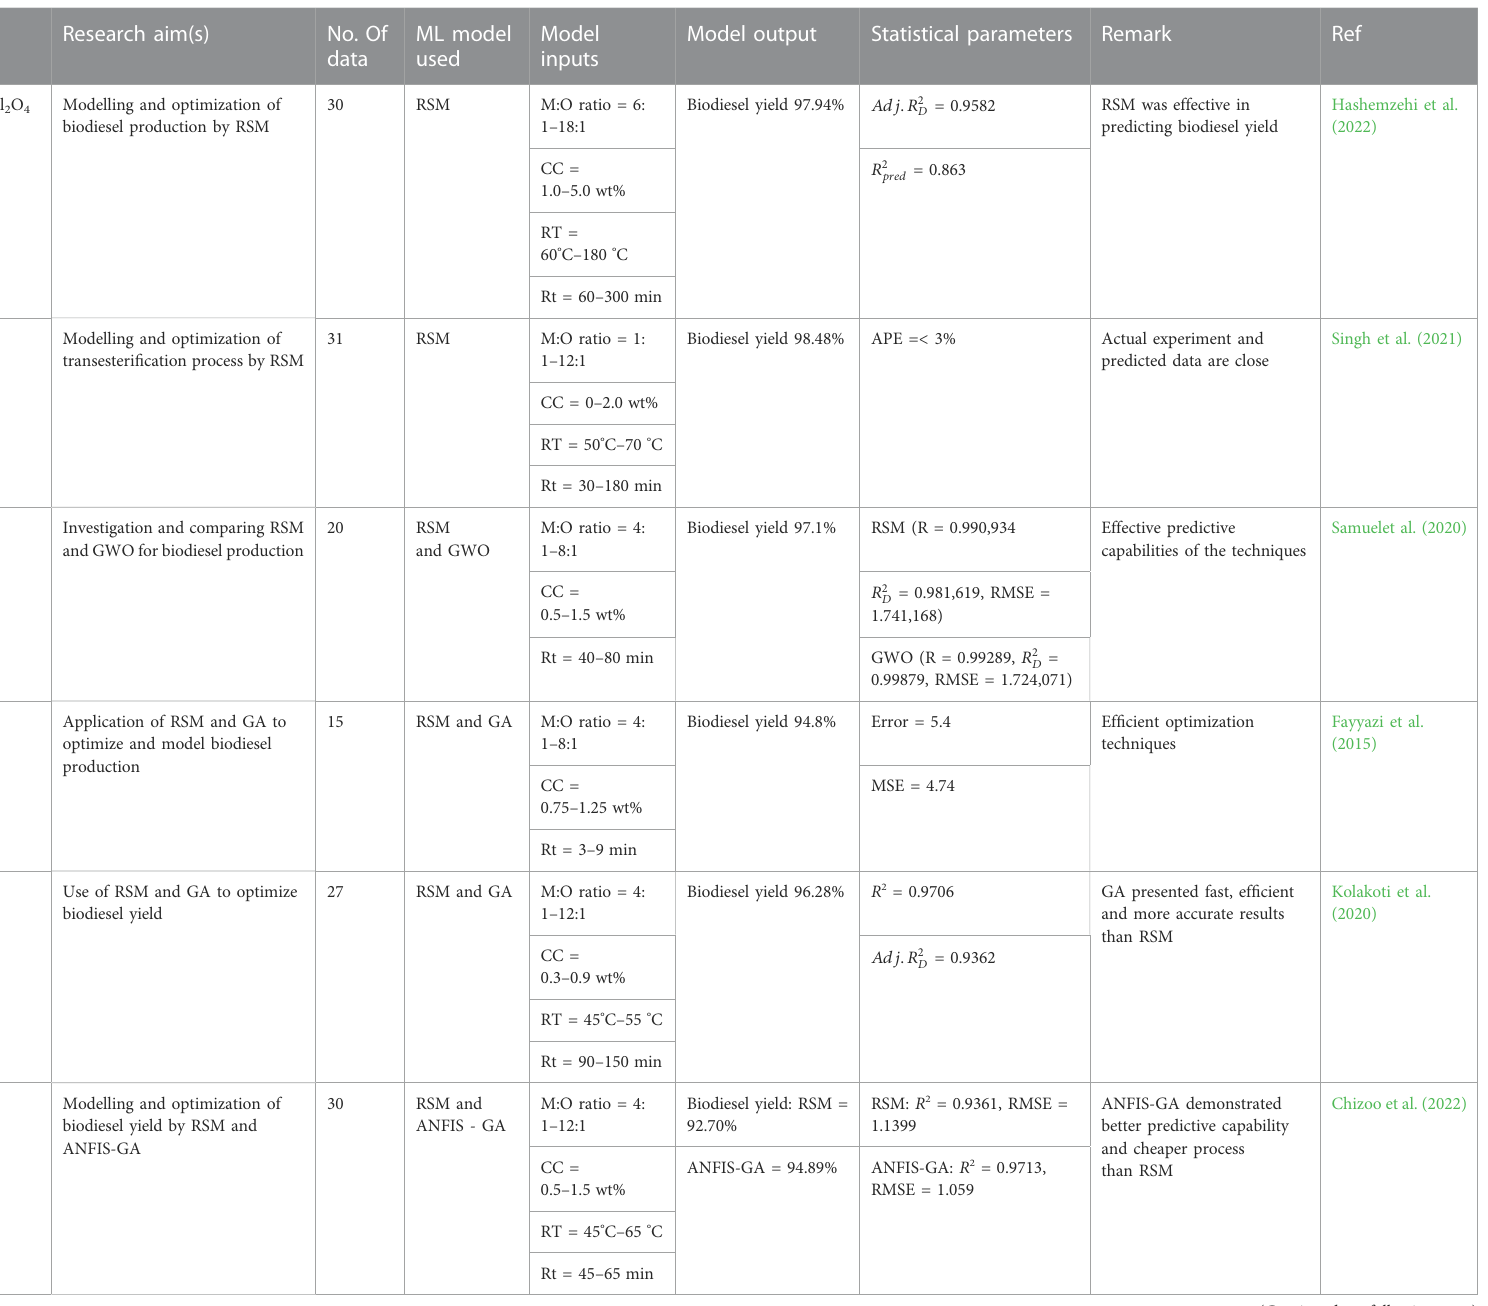
TABLE 6 ( Continued ) Application of ML models for modelling, predicting, and optimizing biodiesel process